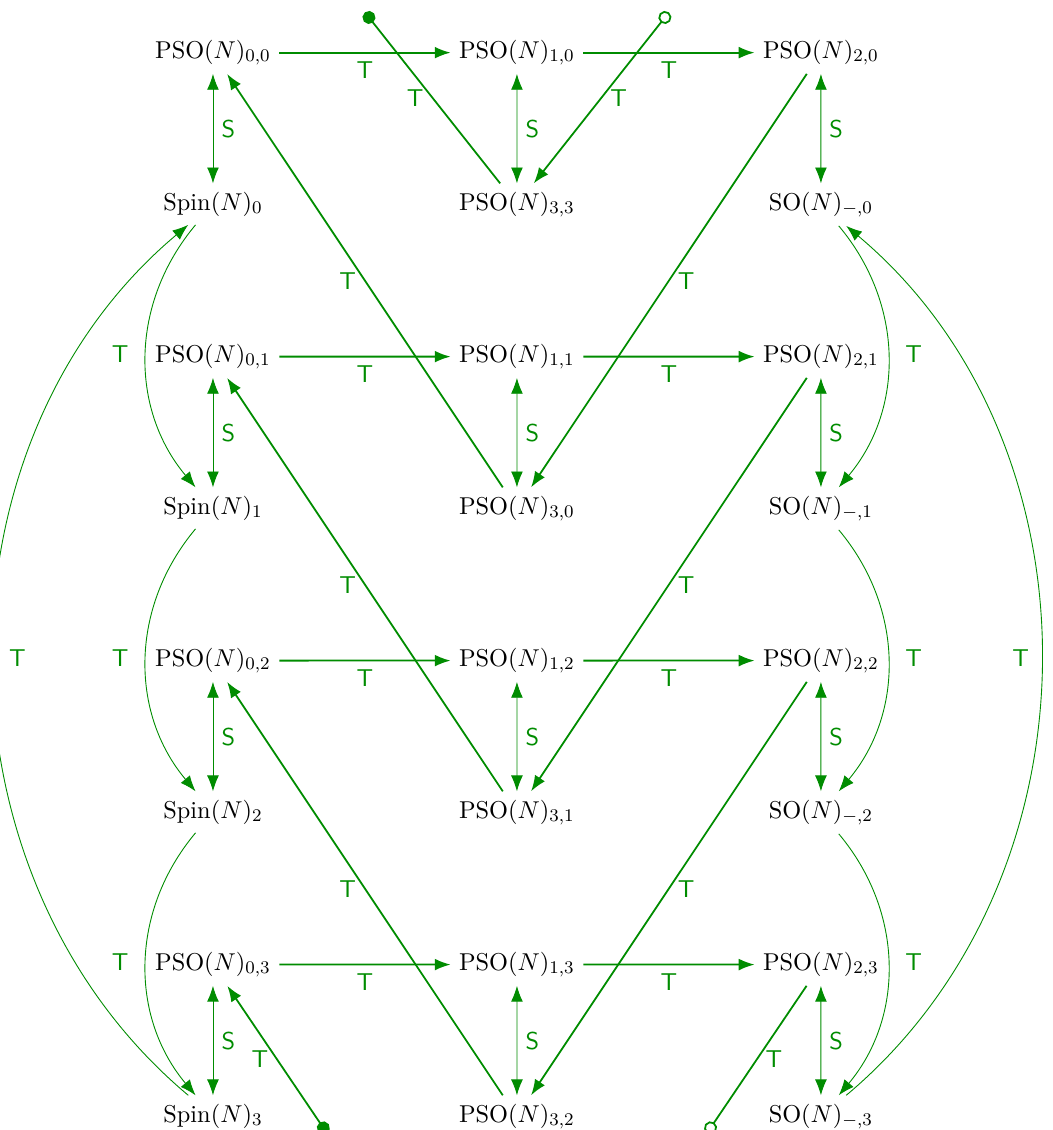
Figure 9 . Web of transformations (quotiented by charge conjugation) for theories with gauge algebra so (4 k + 2) with k odd. To obtain the web for k even, one simply reverses all of the T arrows. Note that S and T denote the standard modular transformations, while Spin( N ) m denotes Spin( N ) coupled to m copies of the primitive invertible phase, and likewise for the other